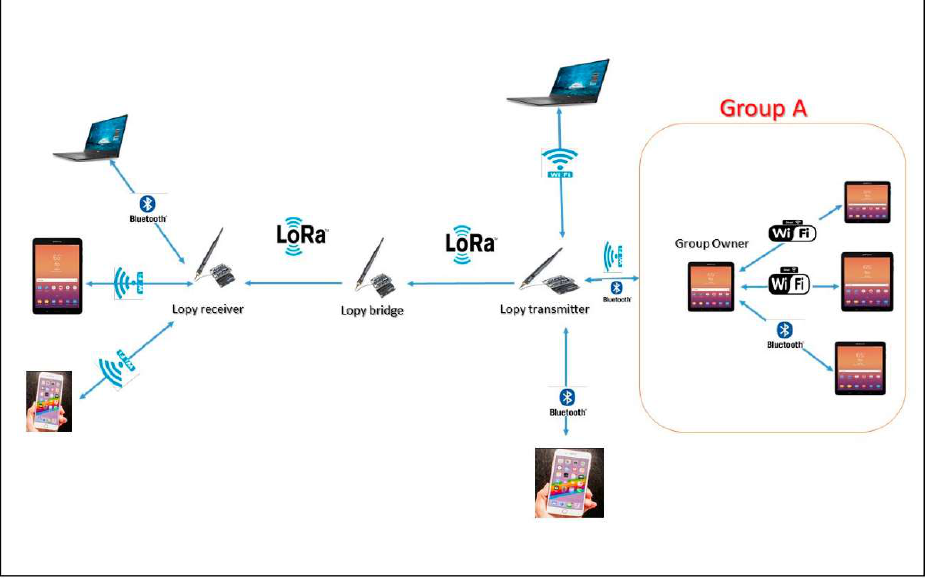
Figure 4. Connectivity Model Structure.